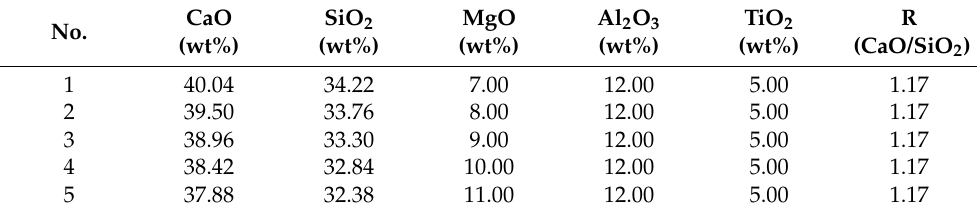
Table 1. Chemical composition of synthesized BF slag.